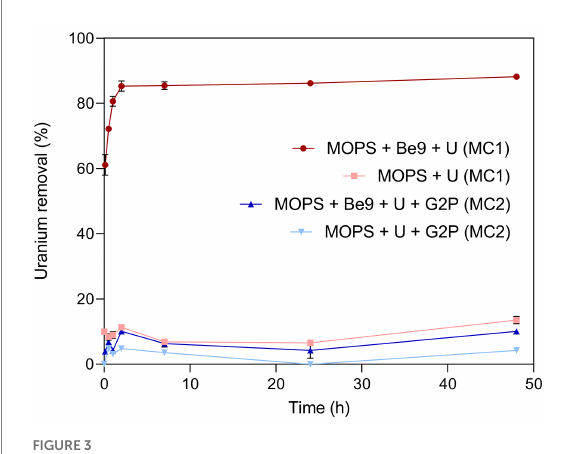
FIGURE 3 Uranium removal efficiency (%) kinetics during MC1 and MC2 conditions assayed. Abiotic treatments were used as control in both conditions. Data are shown as the mean and error bars represent standard error of three independent measurements.